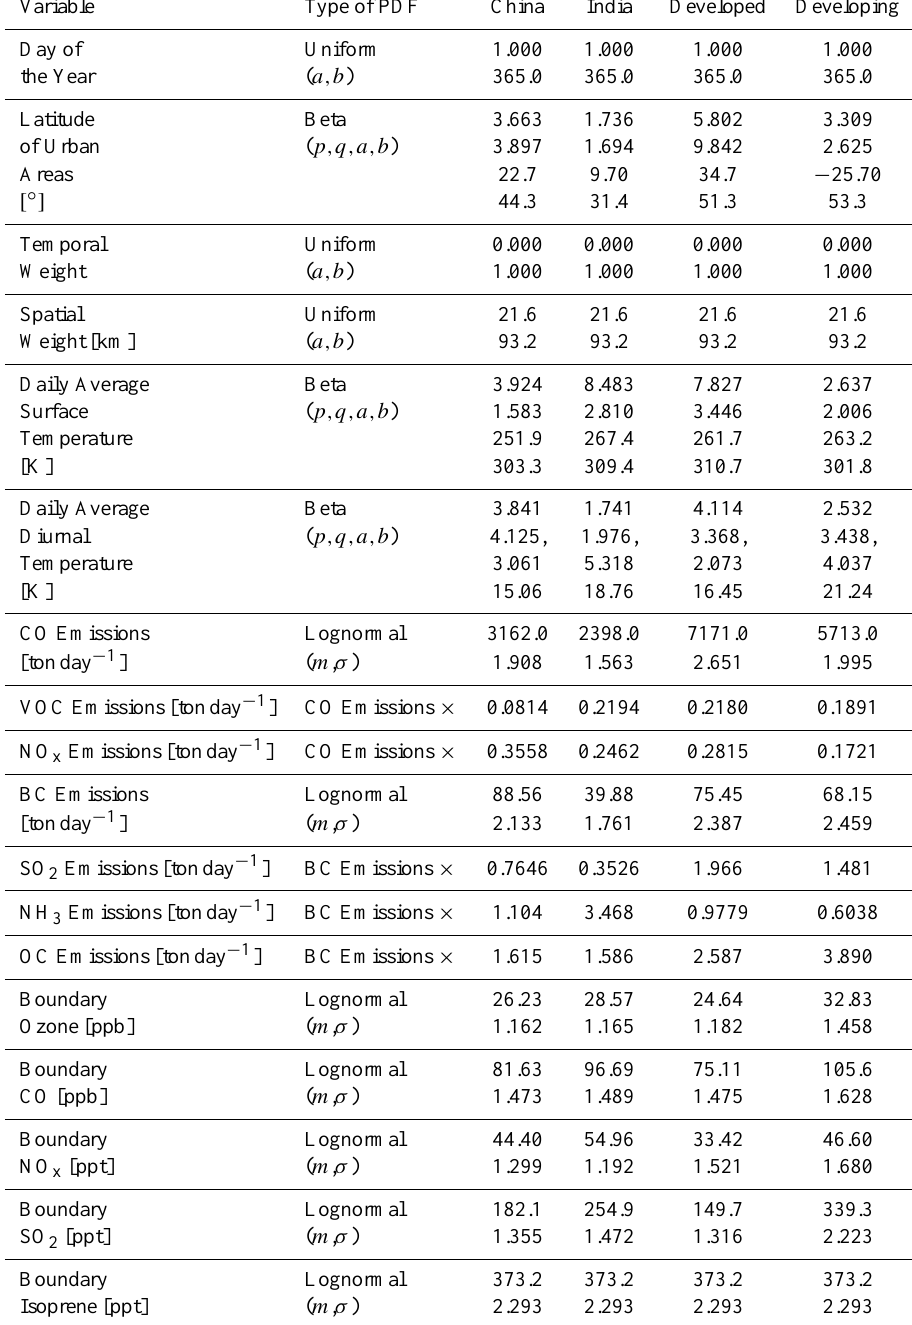
Table 3. Descriptions of and coefficients for the PDFs used to drive the CAMx model. The PDFs are defined based on Eqs. 4, 5, and 6.